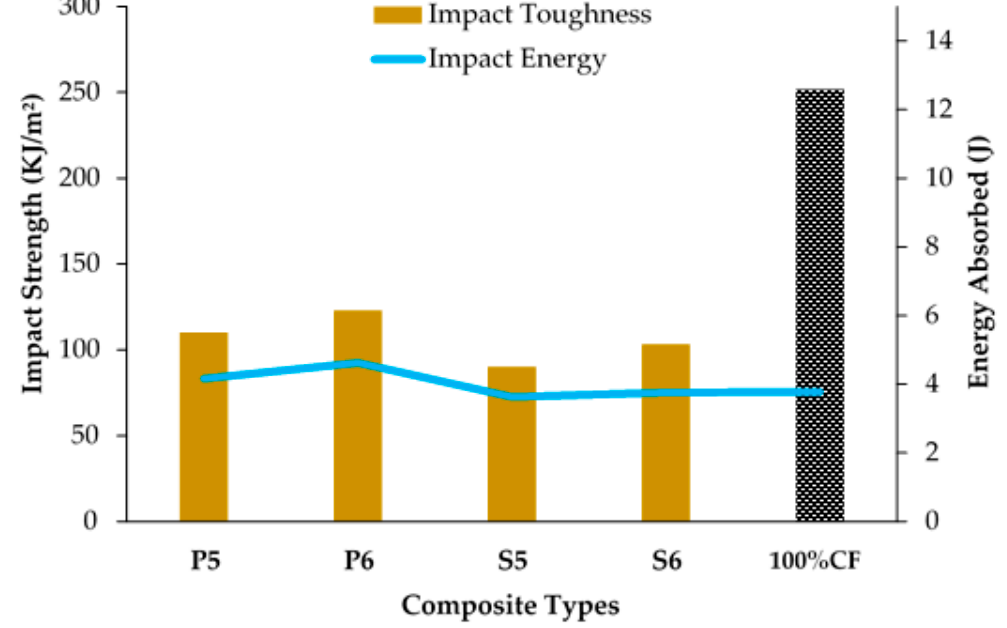
Figure 11. Impact strength and total energy of woven kenaf/carbon fibre hybrid composite and carbon fibre composite.